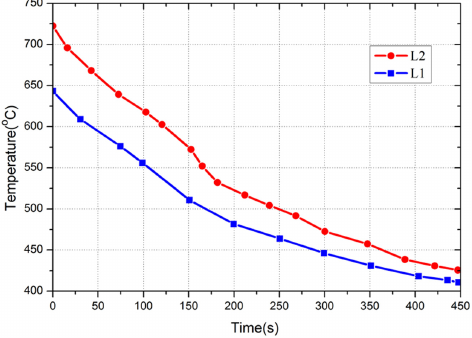
Figure 15. Variation in cool-down temperatures with time according to thermal camera images.